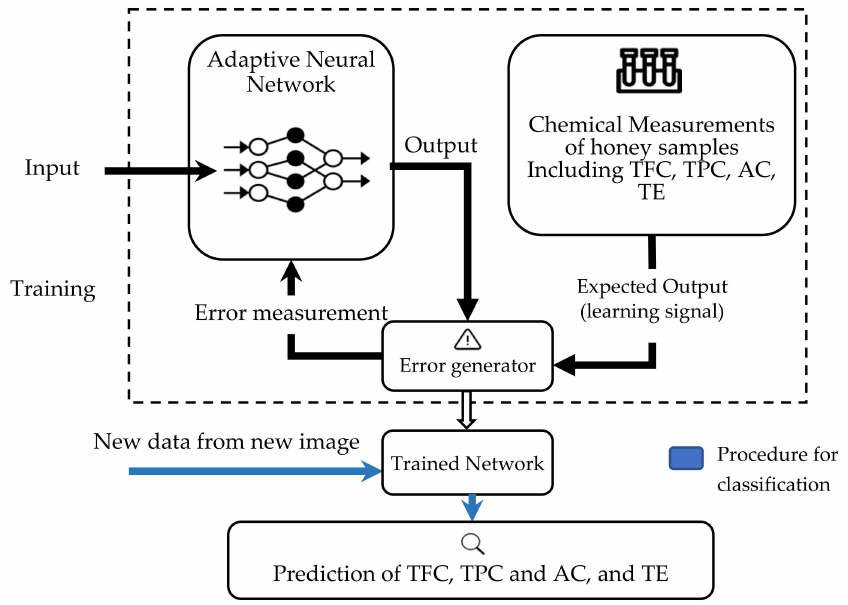
Figure 14. Schematic description of the method for prediction of honey